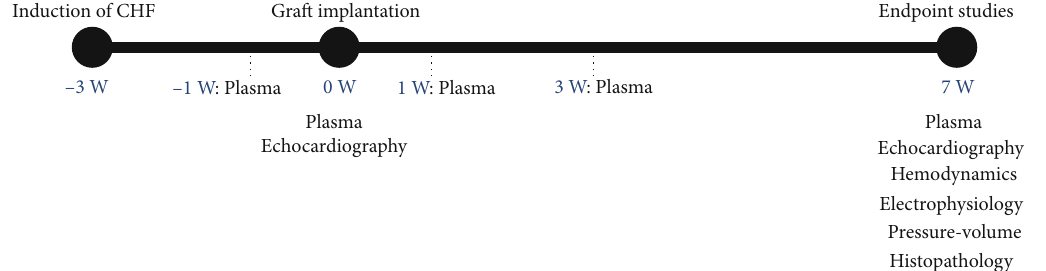
Figure 1: Timeline of rat surgeries. Chronologic study timeline in weeks (W). Sham controls received a thoracotomy at the time of CHF induction but did not undergo permanent coronary occlusion. A portion of CHF control rats were randomly selected to receive the graft therapy. CHF control rats that were not selected for graft therapy still received a sham lateral thoracotomy. Plasma was obtained by removing the superior-most portion of the centrifuged whole blood for antibodies. ( n = 7 ) (Figure 2). The P / V curve from the sham animals was displaced to the left toward the pressure axis, and the CHF